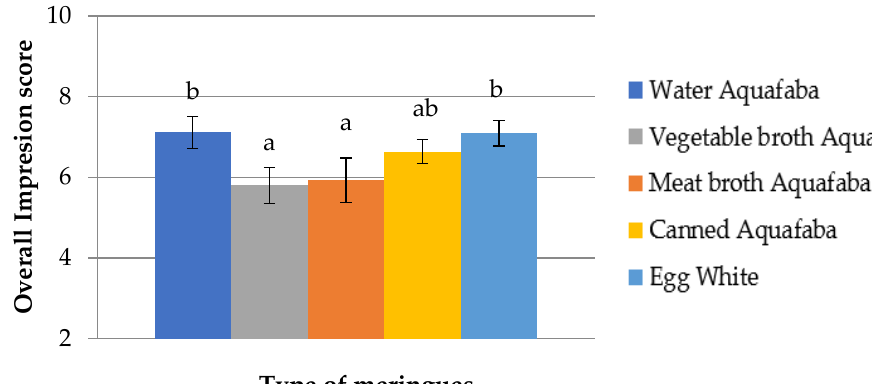
Figure 6. Overall impression scores of meringues made with Pedrosillano chickpea aquafaba and egg white using a rating from 1 (very bad) to 10 (very good). ab Means with different superscripts showed significant differences ( p < 0.05).